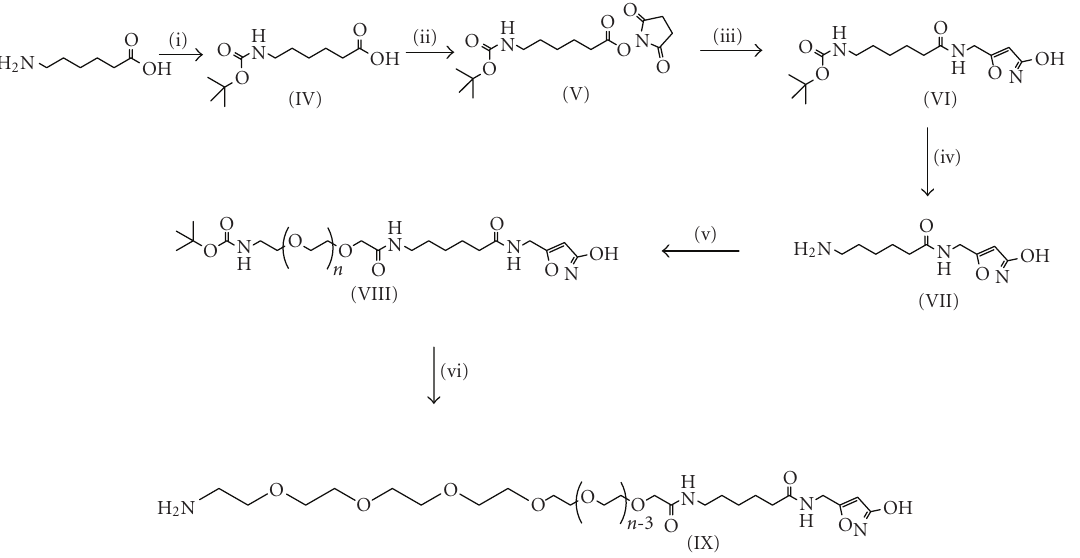
Scheme 2: Synthesis of muscimol ligand: (i) BOC anhydride, (ii) NHS, DCC, (iii) Muscimol, (iv) TFA,(v) BOC-PEG3400-NHS, and